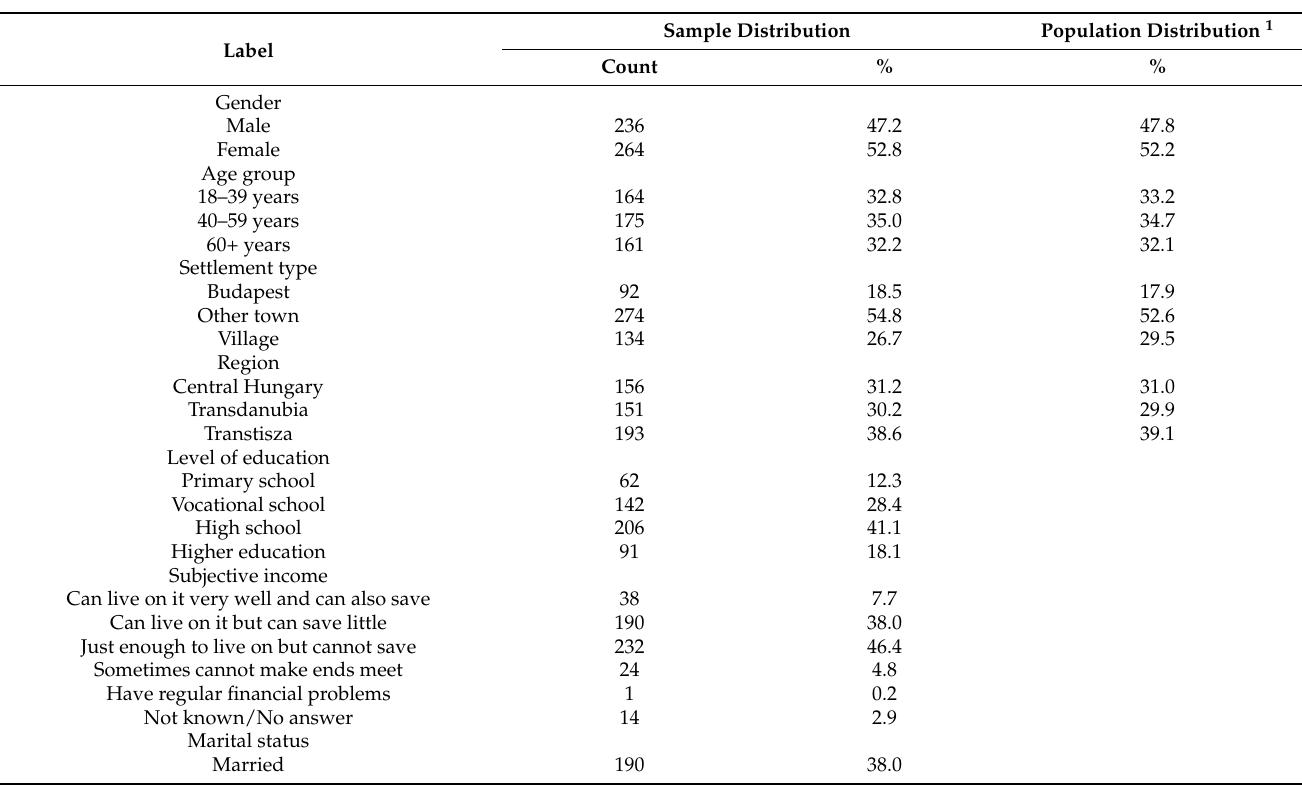
Table 1. Distribution of the sample according to the most important background variables ( n = 500) and population composition according to representative